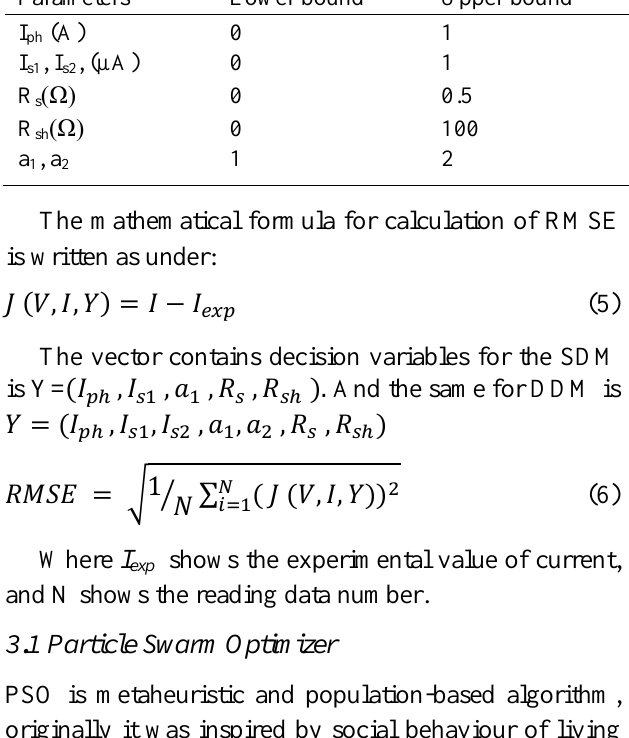
The boundary limits of parameters [1]. Parameters Lower